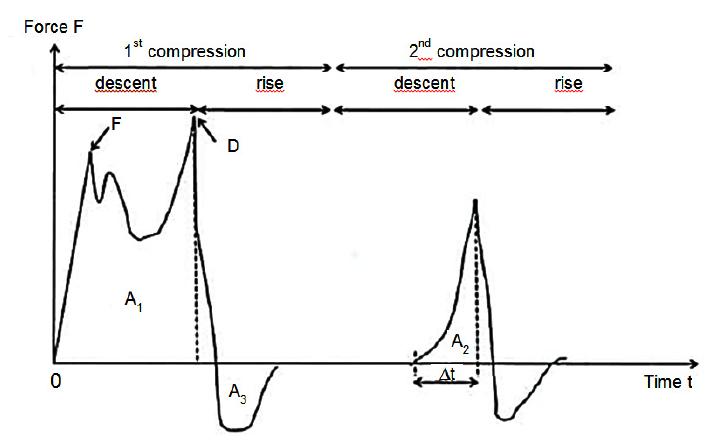
Fig. 2. Typical texture profile after two successive compressions or measurement of TPA “Texture Profile Analysis.” Legend: A = surfaces, D = peak forces, “t = time of actual penetration phase during the second compression table 1. Proportion of ingredients to make brioches: the control brioche (Ctrl+) and the